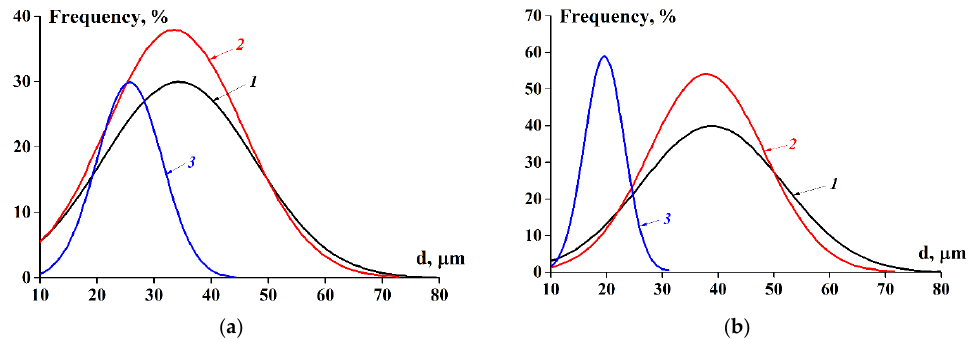
Figure 6. Droplet size distribution for concentrated emulsions stabilised with FPI 20-4 ( a ) and FPI 4-16 ( b ). C(FPI), % ( w / v ): 1—1.0; 2—2.0; and 3—5.0.